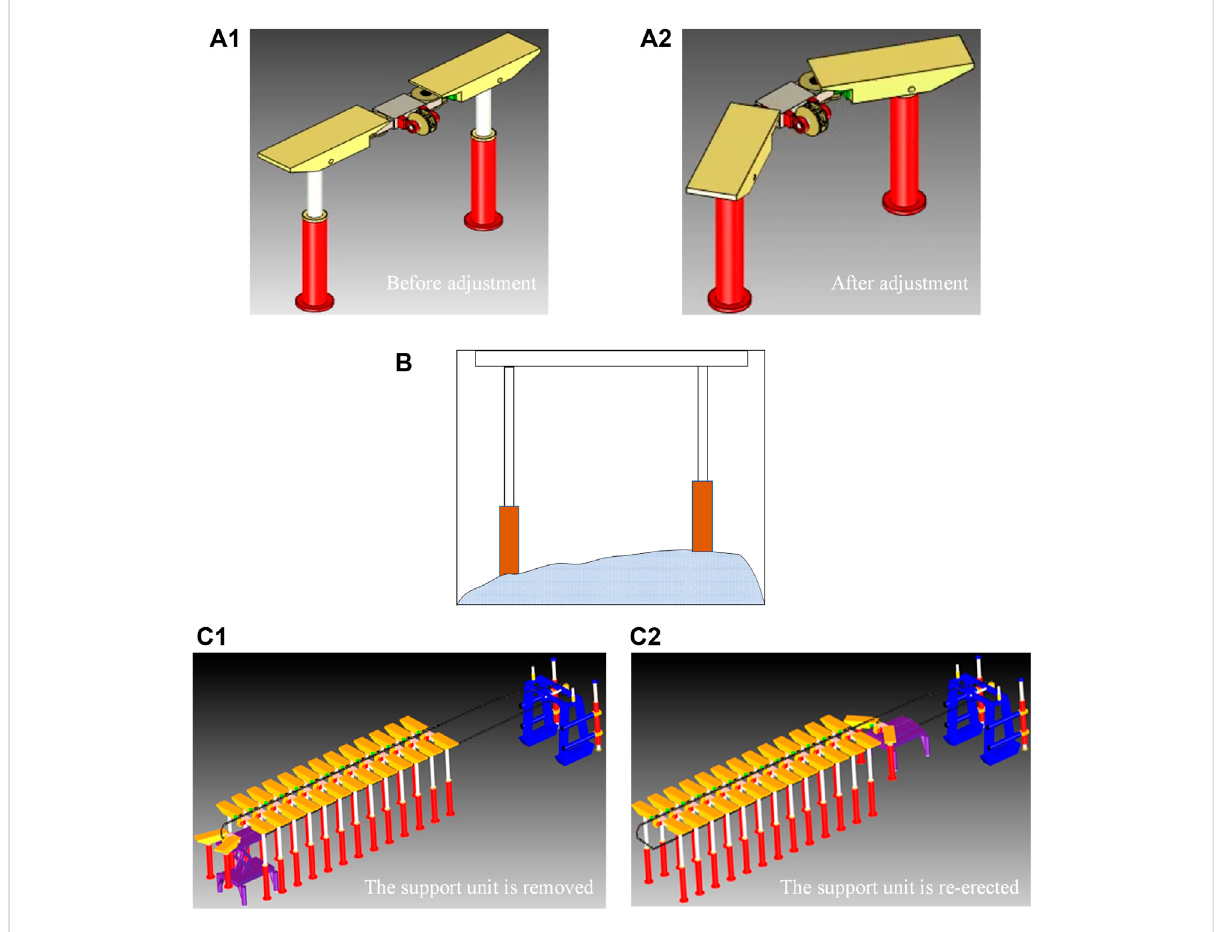
FIGURE 14 Featuresofthesupportsystem. (A) Foldablesupportunit. (B) Supportunitadaptedto fl oorheave. (C) Removalanderectionofthesupportunits.